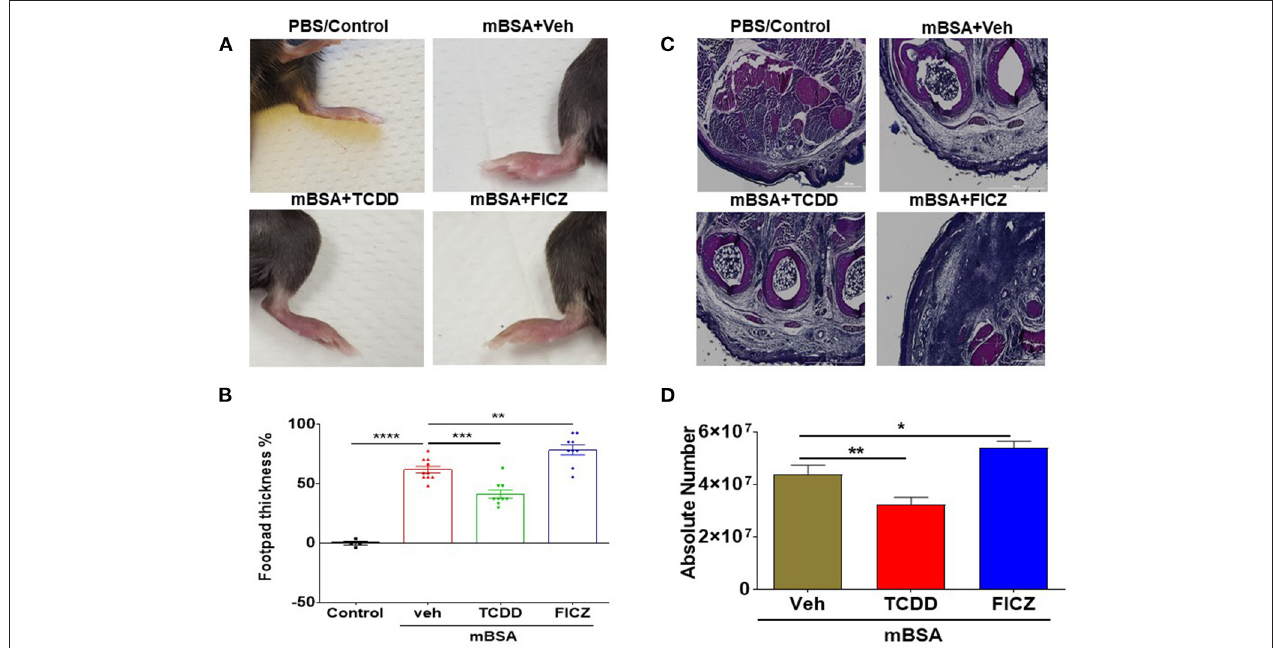
FIGURE 1 | AhR ligands (TCDD and FICZ) have opposite effects on mBSA-induced DTH in mice. DTH was induced by injecting mBSA and these mice were treated with vehicle, TCDD or FICZ, as detailed in Methods. (A) Shows footpad thickness in mice with DTH. (B) Showing the percentage change in footpad thickness in all the groups of mice. (C) H&E (4X magnification) staining of histological sections of footpads from all the four groups of mice. (D) Absolute cell number of cells in draining lymph nodes of various groups. Vertical Bars represent Mean ± SEM and significant difference in total cell numbers are shown with asterisks (* p < 0.05, ** p < 0.01, *** p < 0.001, **** p < 0.0001) based on one-way